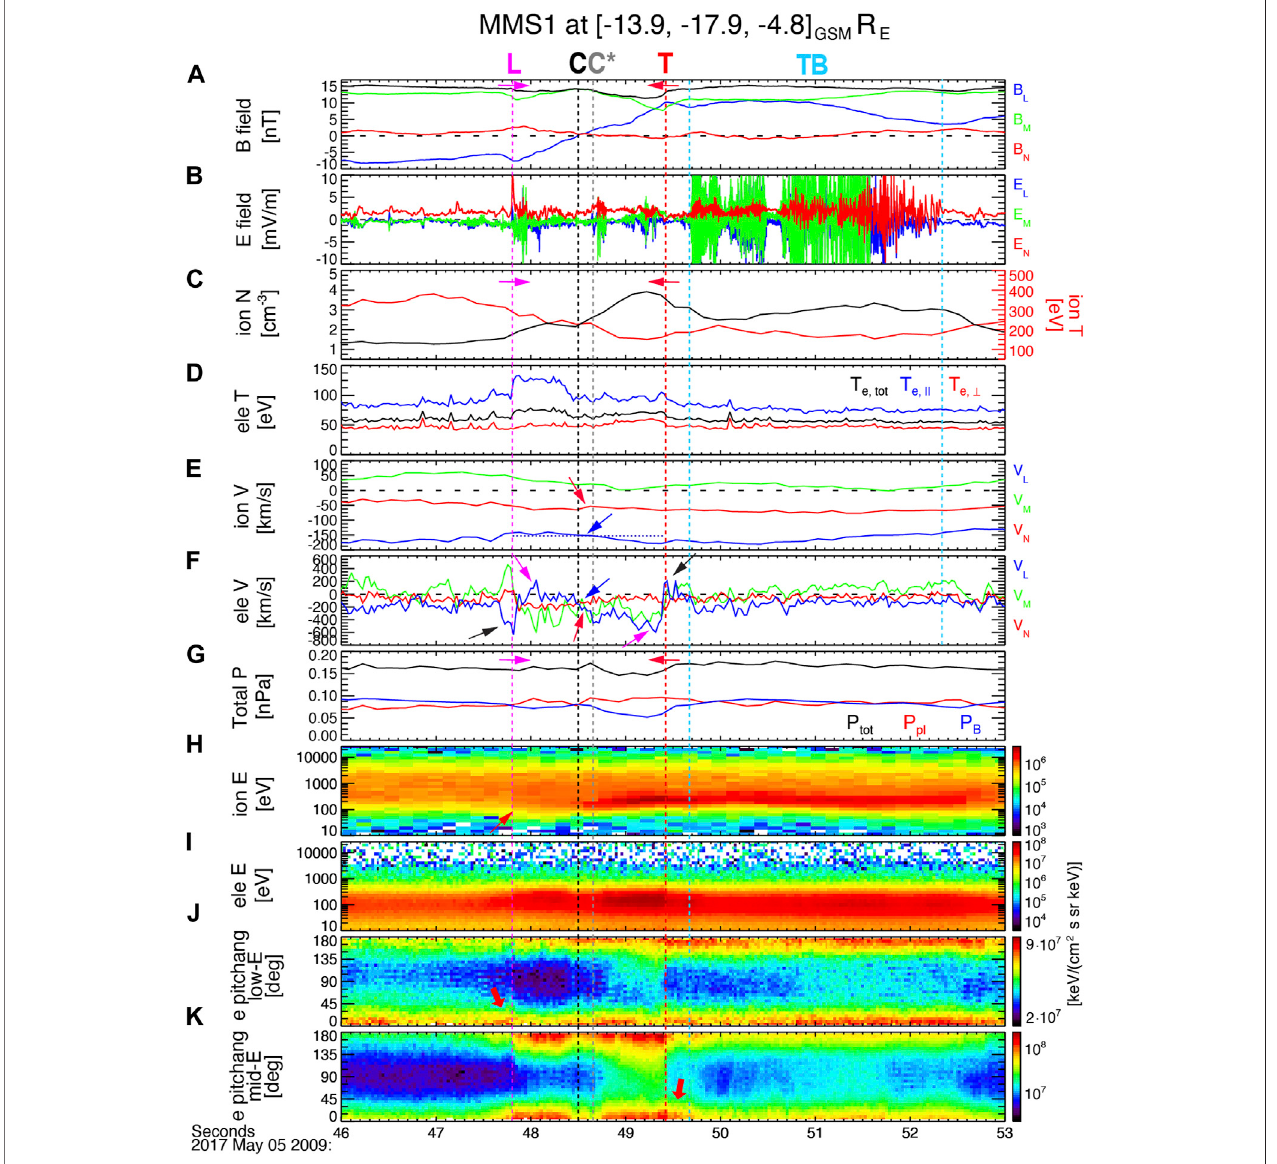
FIGURE 3 | MMS1 observation on May 5,2,017 during 2009:46 – 53 UT: (A,B) the l (blue), m (green), and n (red) components of the magnetic fi eld ( B ) and the electric fi eld ( E ) in LMN; (C) the ion density (black) and temperature (red); (D) the electron total (black), parallel (bule), and perpendicular (red) temperature; (E) the ion velocity; (F) the electron velocity; (G) the plasma (red) and magnetic (blue) pressures, and the sum (black) of these pressures; (H) the ion energy spectrogram; (I) the electron energy spectrogram; (J,K) pitch angle distributions of the low- ( ∼ 10 eV ≤ energy < 200 eV; J ), mid- (200 eV ≤ energy < 2 keV; K ) energy electrons.